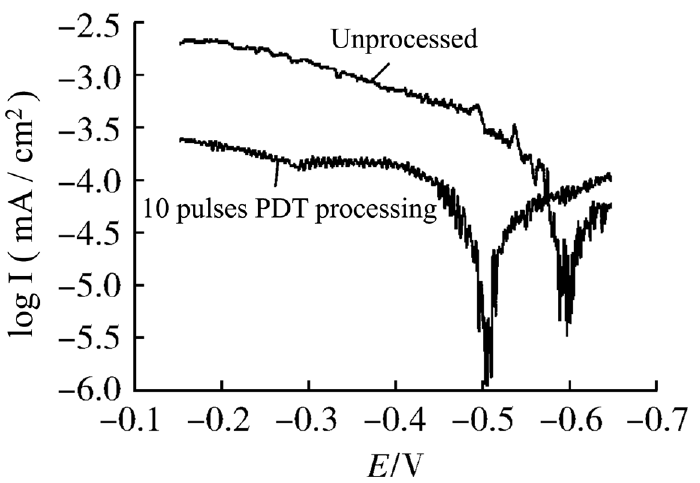
Figure 5. The dynamic potential polarization curves of M2 HSS before and after PDT [51]. Pitting corrosion is a common kind of corrosion on metal surfaces. The pitting corro- sion is strongly attributed to the material inhomogeneity (casting defects, differences in grain structure, inclusions, gran boundary defects, etc.) on the surface of the metal sample. The predominant cracking initiation caused by pitting corrosion can be correlated to the primary austenite grain boundaries, as these sites are normally weaker in martensitic